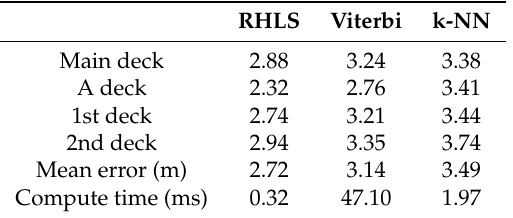
Figure 12. Hybrid positioning result example by deck: ( a ) main deck; ( b ) A deck; ( c ) first deck; ( d ) second deck. Table 1. Positioning accuracy by deck. k-NN—k-nearest neighbor.